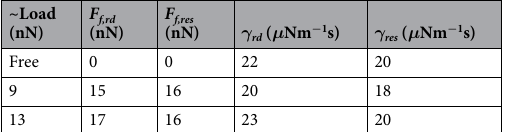
Table 1. Fitting parameters extracted from several ring down and transfer function experiments, with different normal loads applied to the oscillator. Suffix ‘rd’ represents ‘ from ring down curves’ and ‘res’ represents from ‘resonance